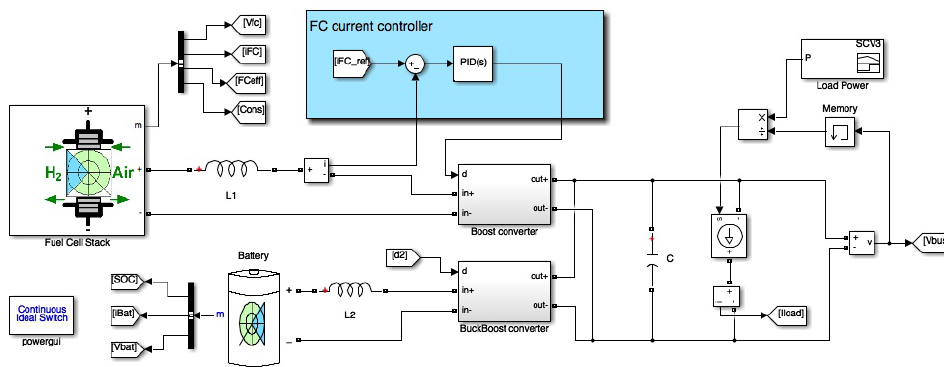
Figure 23. Full-active hybrid powertrain simulation circuit.